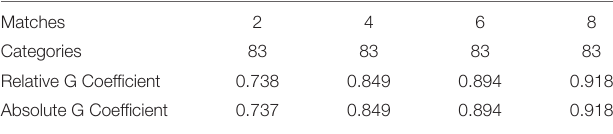
TABLE 4 | Evolution of the generalization coefficient as a function of the number of matches to be